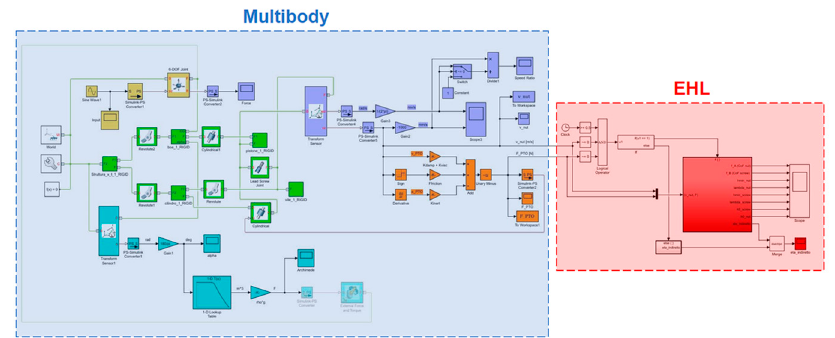
Figure 6. Integration between multibody and EHL models.